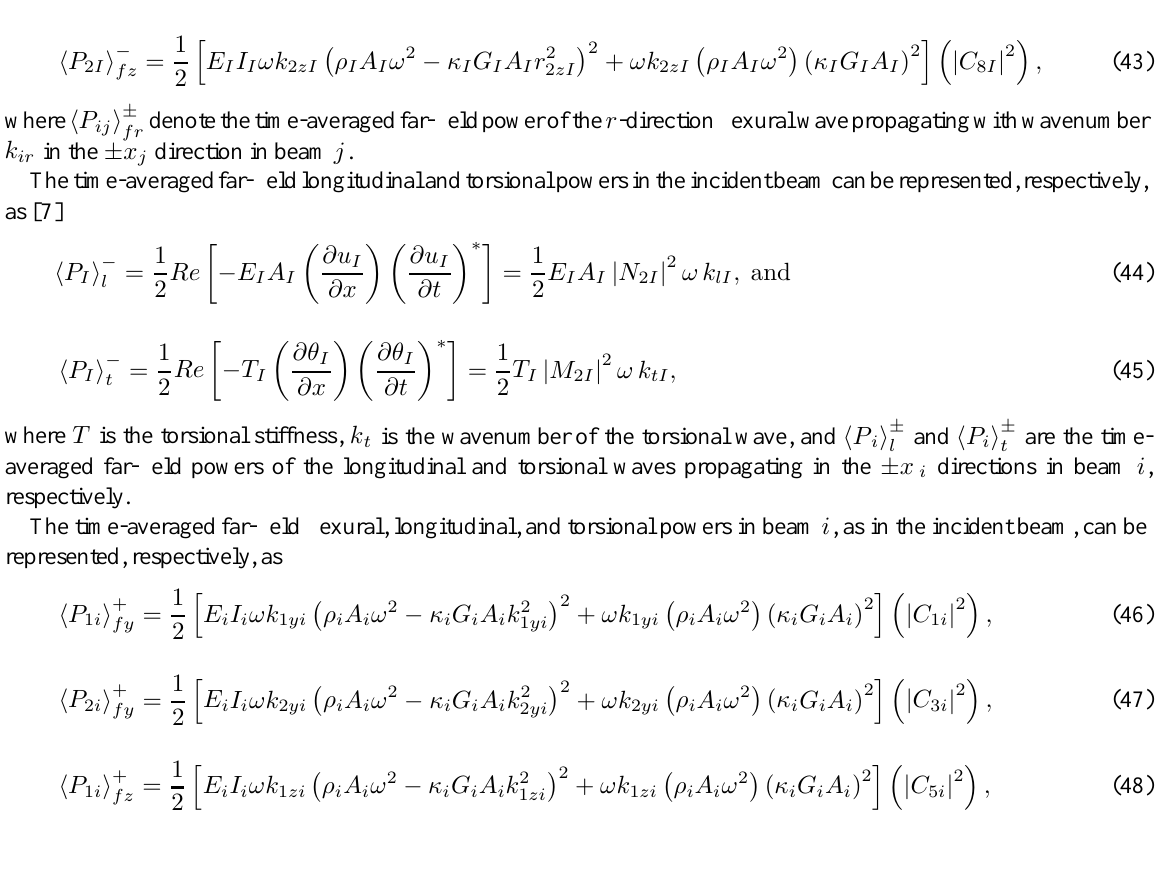
Fig. 7, continued. The power transmission and reflection coefficients of two semi-infinite Timoshenko beams with different material and geometrical properties joined at 90 ◦ : (a) Case of the incident BDFW with wavenumber k 1 , (b) Case of the incident SDFW with wavenumber k 2 , (c) Case of the incident longitudinal